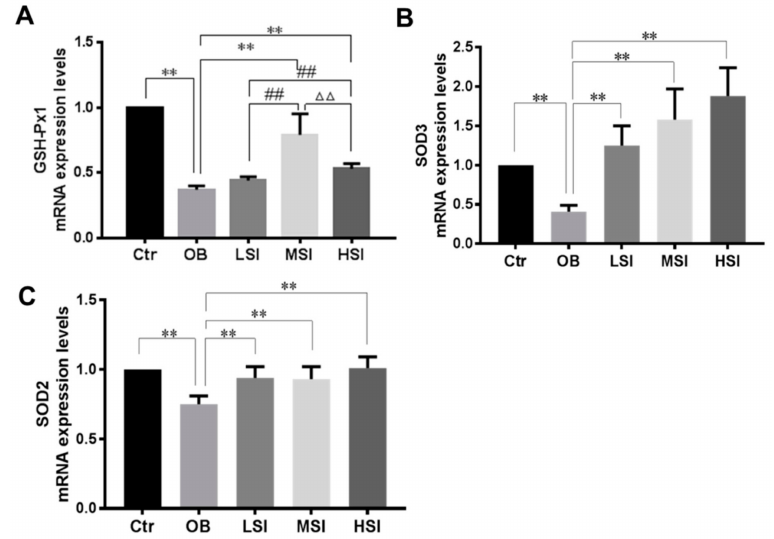
Figure 4. E ff ect of SIF on mRNA expression level of ( A ) GSH-Px1, ( B ) SOD3, ( C ) SOD2 ( n = 8). Bars represent the mean ± SD, * p < 0.05, ** p < 0.01 vs. OB; # p < 0.05, ## p < 0.01 vs. LSI; ∆ p < 0.05, ∆∆ p < 0.05 vs. MSI, one-way ANOVA analysis and LSD